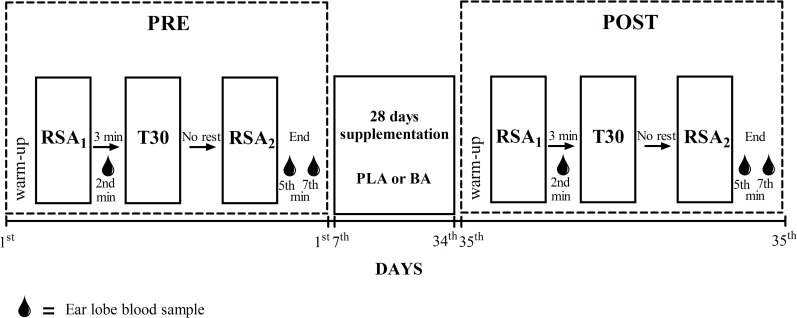
Time line and schematic of the tests.RSA1 = RSA test performed before T30; RSA2 = RSA test performed after T30; T30 = 30-minute swimming test.